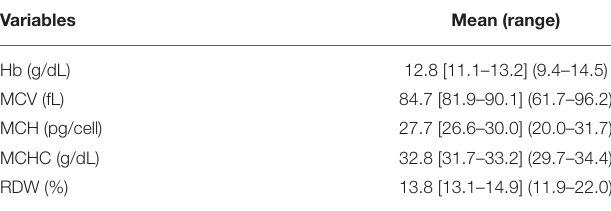
TABLE 4 | Baseline red blood cell count variables of patients with RTT ( n =